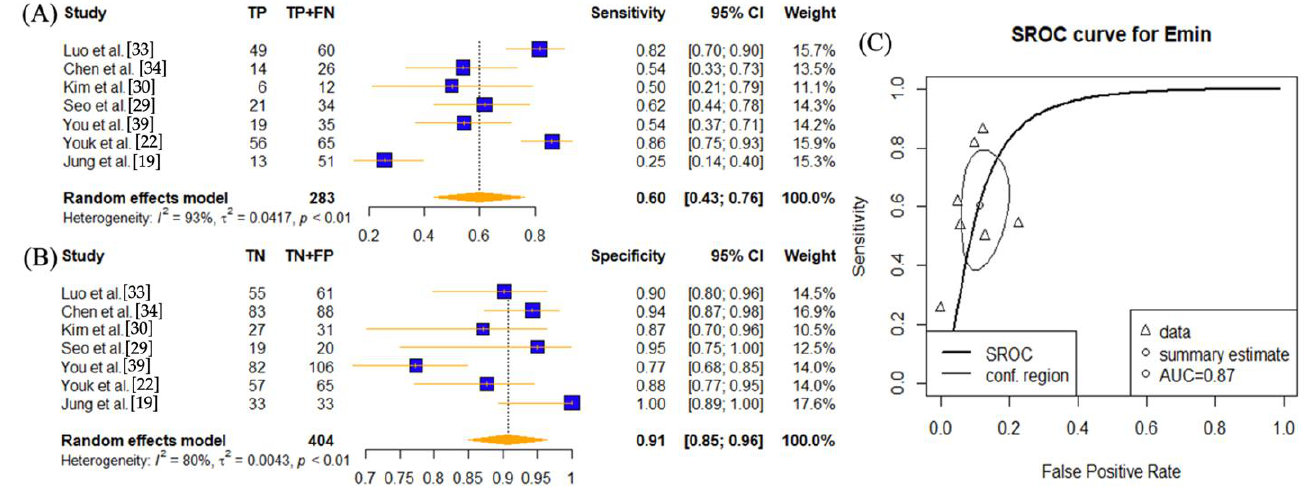
Figure 4. Sensitivity and specificity forest plots and overall accuracy results of E min . (( A – C ) Reported sensitivity and specificity values for E min values per selected study with AUC value on SROC curve for the analysis of E min . Forest plots for pooled sensitivities and specificities are displayed as diamonds in the graphs for E min ( A , B ). The SROC curve indicates the summary estimates in circles (( C ) for E min ). Triangles represent included study with dotted lines representing the confidence interval and solid line for the SROC. AUC value is displayed (in the legend). E min — minimum tissue stiffness SWE parameter; AUC — area under the curve; SROC — summary receiver operating characteristic.